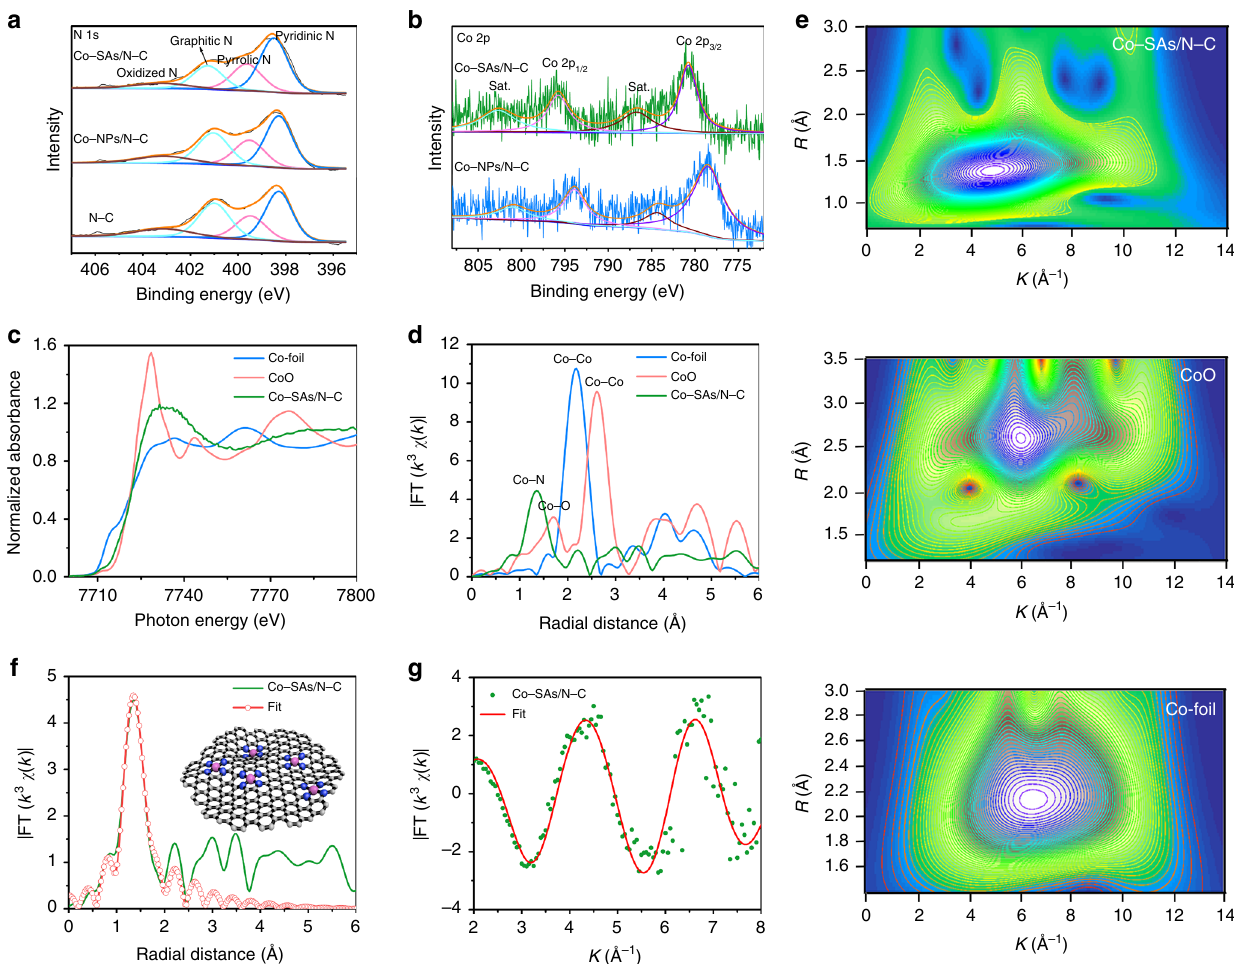
Fig. 2 XPS and XAFS measurements of catalysts. a High-resolution XPS N 1s spectra of Co-SAs/N-C, Co-NPs/N-C and N/C. b High-resolution XPS Co 2p spectra of Co-SAs/N-C, Co-NPs/N-C and N/C. c The normalized K-edge XANES and d K-edge FT-EXAFS in R space for Co-SAs/N-C and Co-foil, and CoO reference samples. e Wavelet transforms for the k 3 -weighted EXAFS signals. f , g Corresponding EXAFS fi tting curves at R and K space, respectively, inset showing the schematic model (The pink, bule, and gray balls stand for Co, N, C, capacity of 20,105 mAh g − 1 and recharge capacity of 19,765 mAh g − 1 . The corresponding coulombic ef fi ciency closes to 100%, far better than those of Co-NPs/N-C (17,160 mAh g − 1 , 10,417 mAh g − 1 , 60.7%) and N-C (17,400 mAh g − 1 , 10,893 mAh g − 1 , 62.6%)